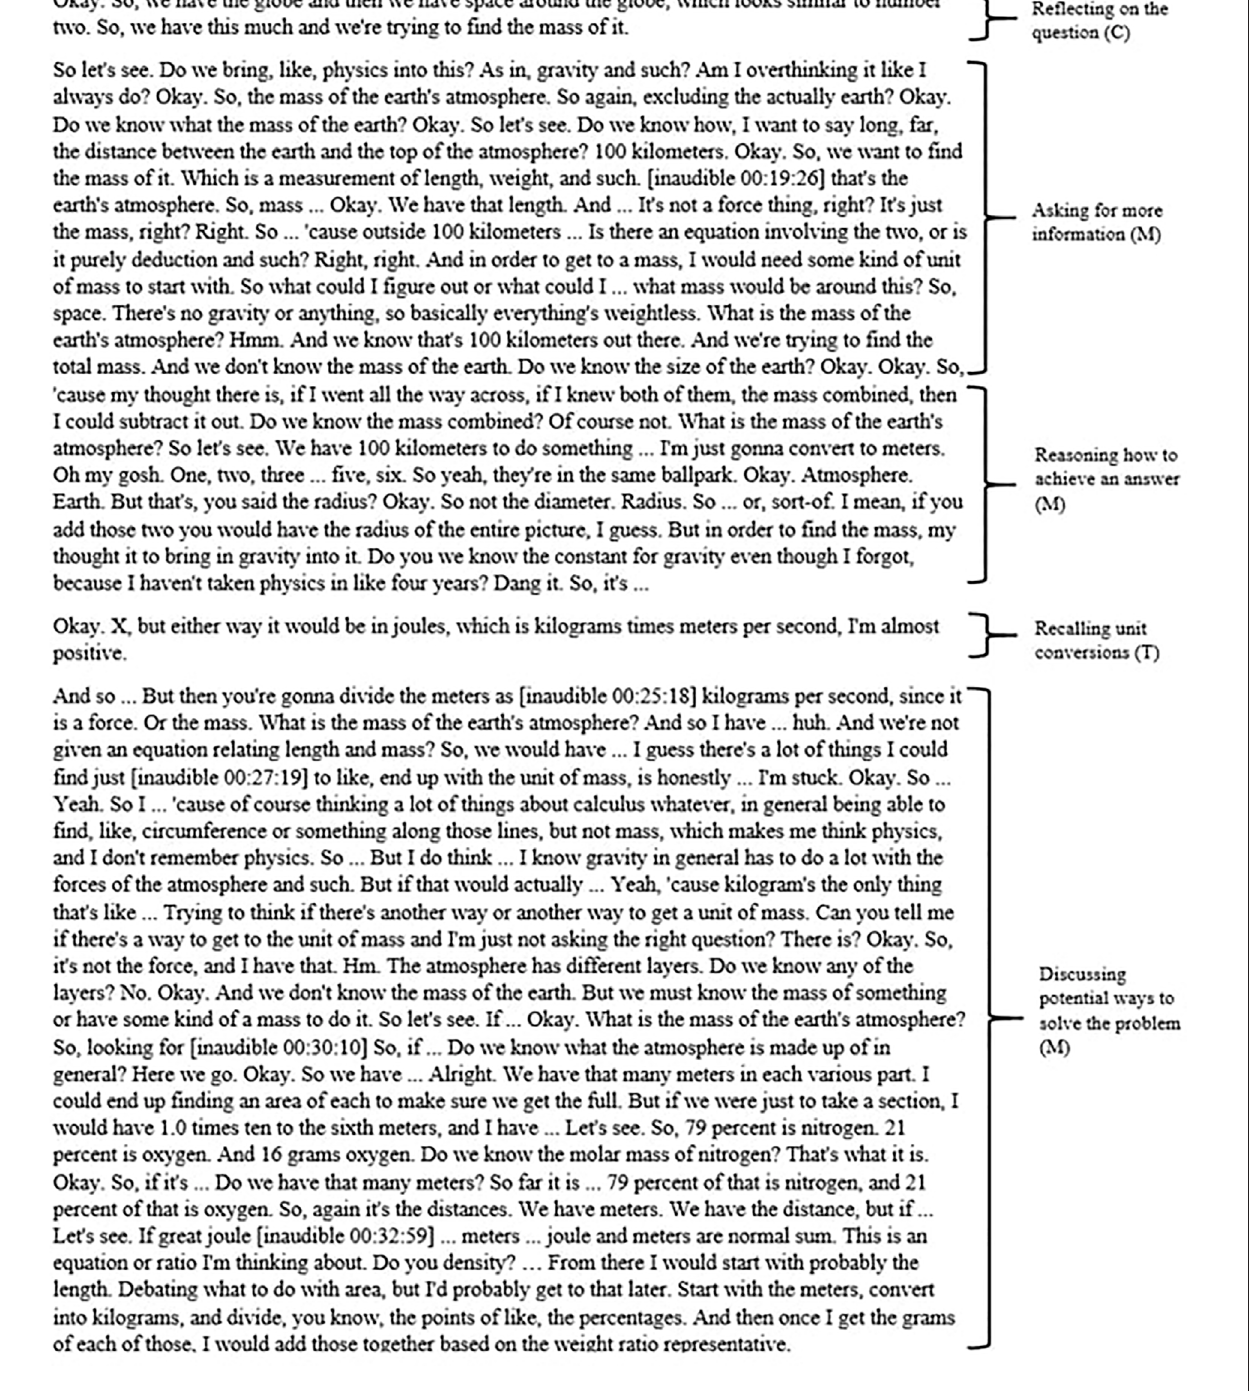
FIGURE 3 | Student excerpt of problem-solving (participant 6, question 3) to demonstrate the connections between MAtCH components and their effects on impeding problem-solving.